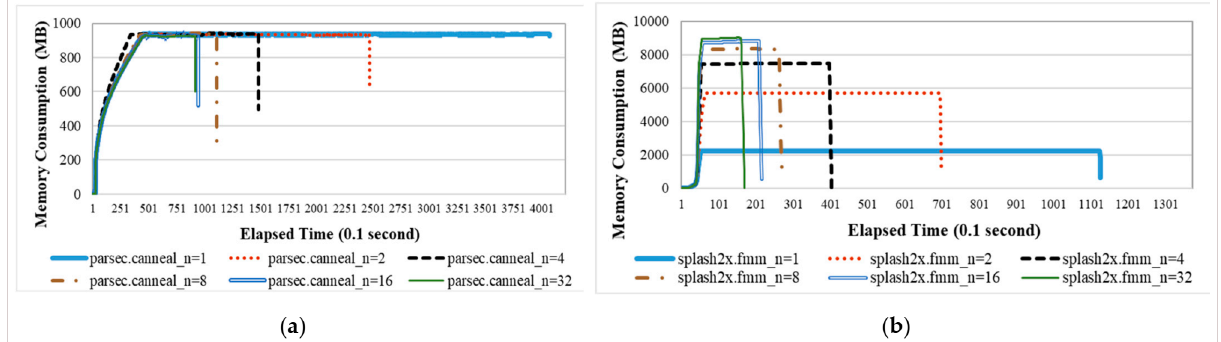
Figure 6. Memory consumption for benchmark programs running with different numbers of threads. ( a ) parsec.canneal; ( b )